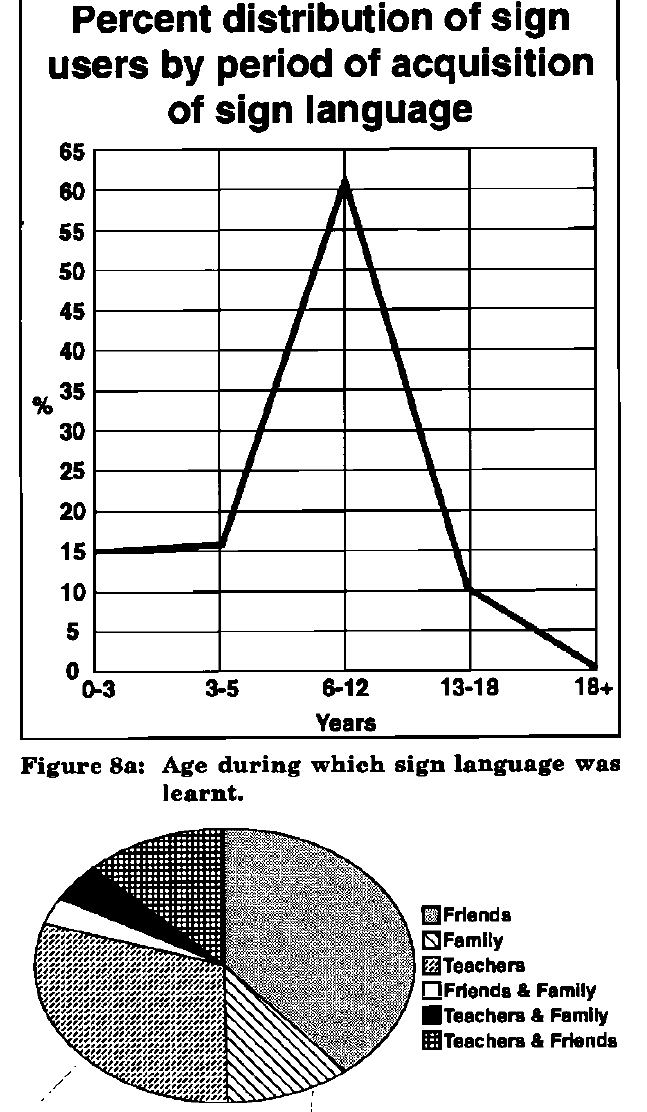
Figure 8b: Primary Educators of Sign Language. areas of education the situation for the black deaf child with the advent of the group areas act and the